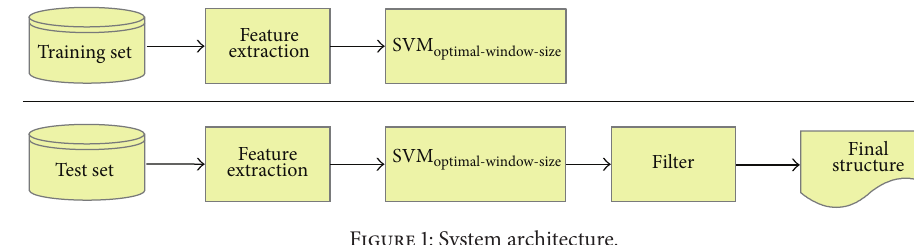
Figure 1: System architecture.